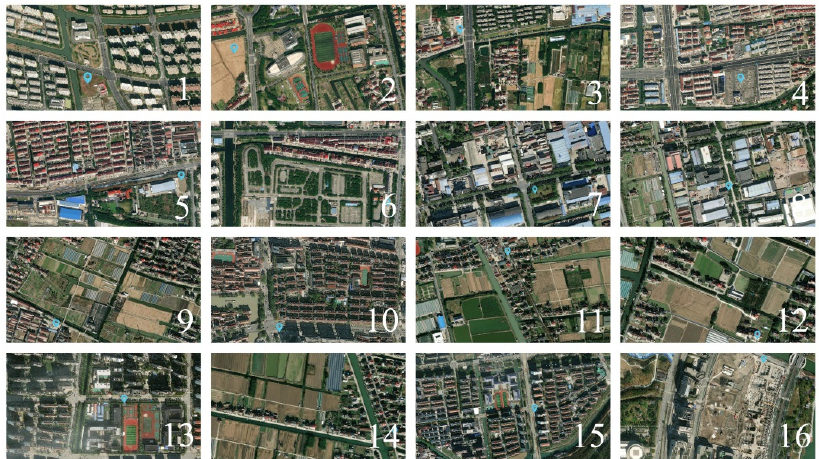
Figure 15. Correction of each ideal point in the observation map.